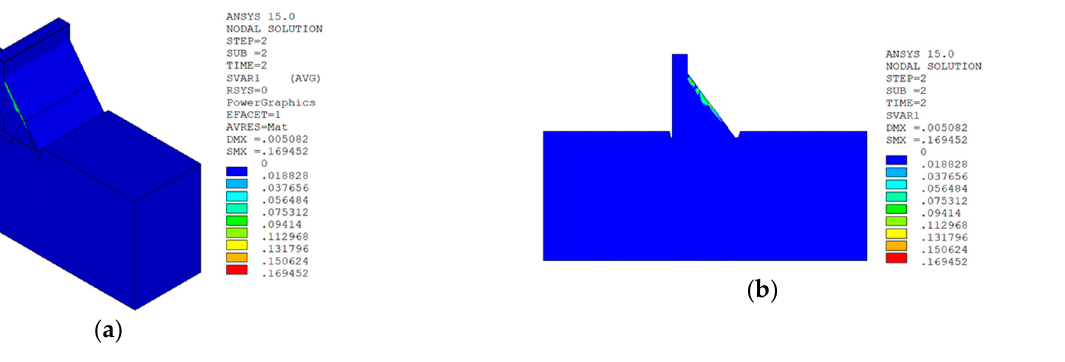
( b ) ( c ) Figure 26. The cloud charts of the three principal strains on the section z = 21 m are calculated by the macro model under the temperature rise condition, ( a ) The cloud chart of the first principal strain, ( b ) The cloud chart of the second principal strain, ( c ) The cloud chart of the third principal strain. Result Analysis It can be seen from Figure 23 that under the working condition of “normal water level + sudden temperature drop”, a certain degree of damage will occur at the surface concrete of the downstream dam body contacting air, with the maximum damage value